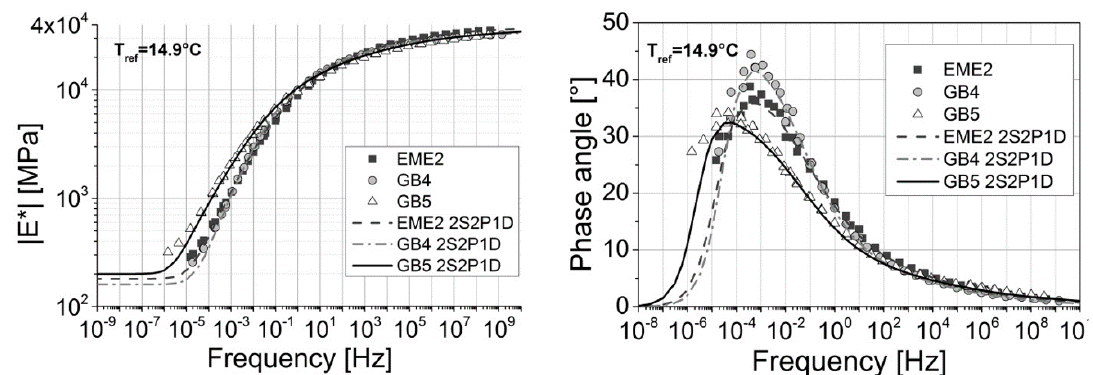
Figure 11. Master curves of the complex modulus (left) and phase angle